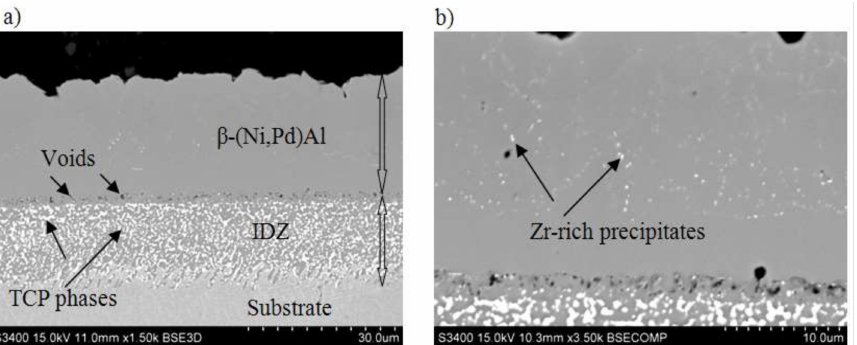
Figure 3. SEM-BSE microstructure on the cross-section of the palladium and zirconium co-doped aluminide coating ( a ) additive zone ( b